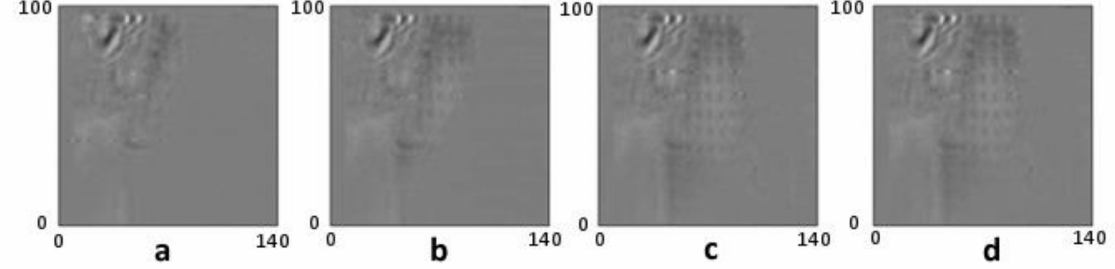
Figure 24. Di ff erential THz images of the mosaic mock-up, obtained by subtracting the dry image from the images taken 5 ( a ), 10 ( b ), 15 ( c ) and 60 ( d ) minutes after the injection of water. Size of the images: 140 × 100 mm 2 . Step size 1 mm.